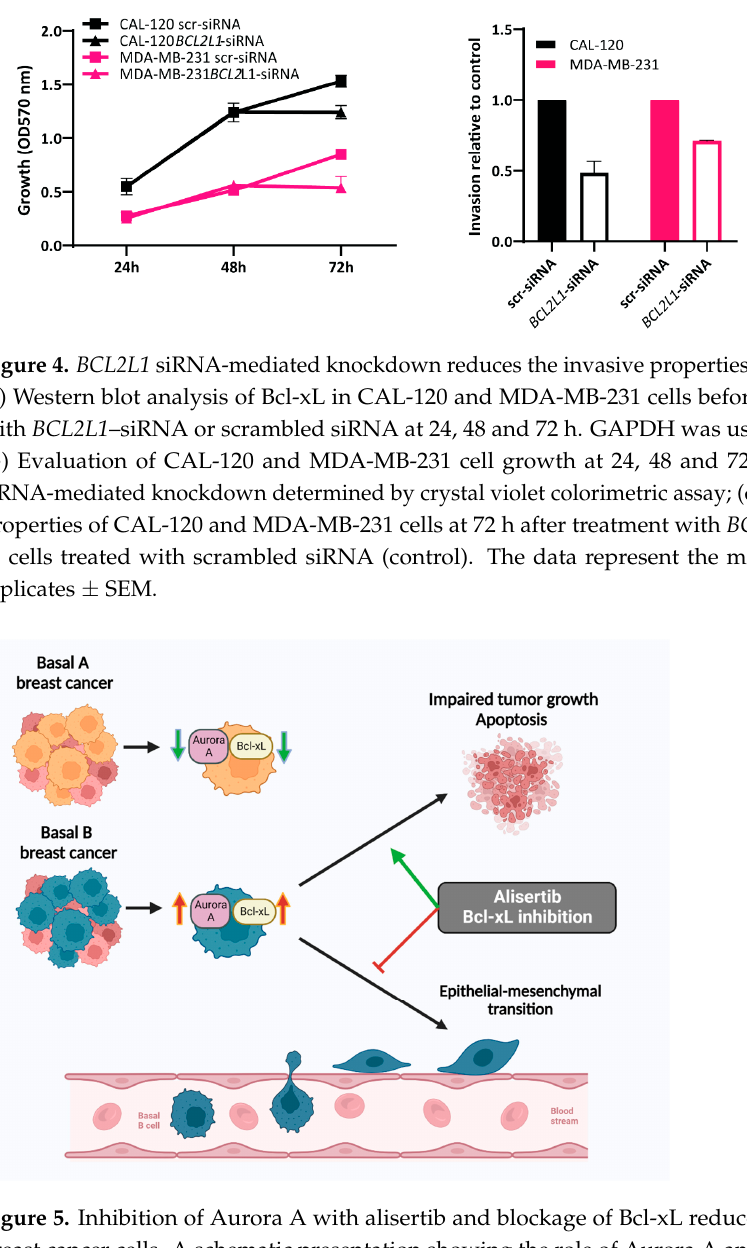
free survival (DMFS, n = 424, p = 0.0055) in TNBC patients (Figure 6a). High